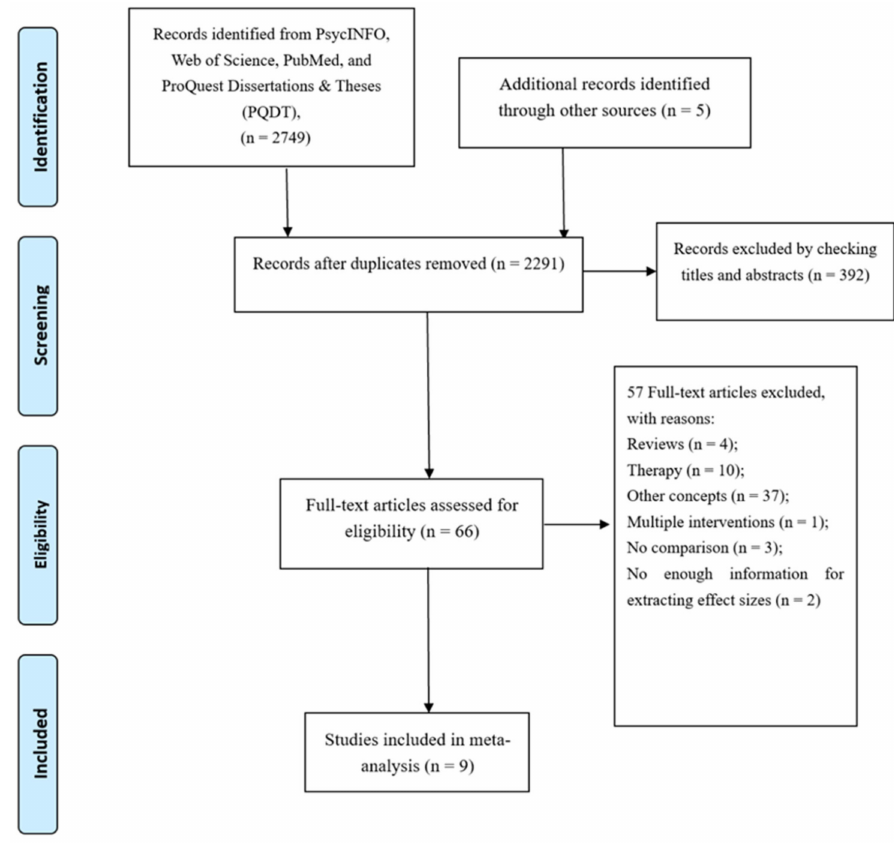
Figure 1. Flow diagram of the search strategy and study selection in this